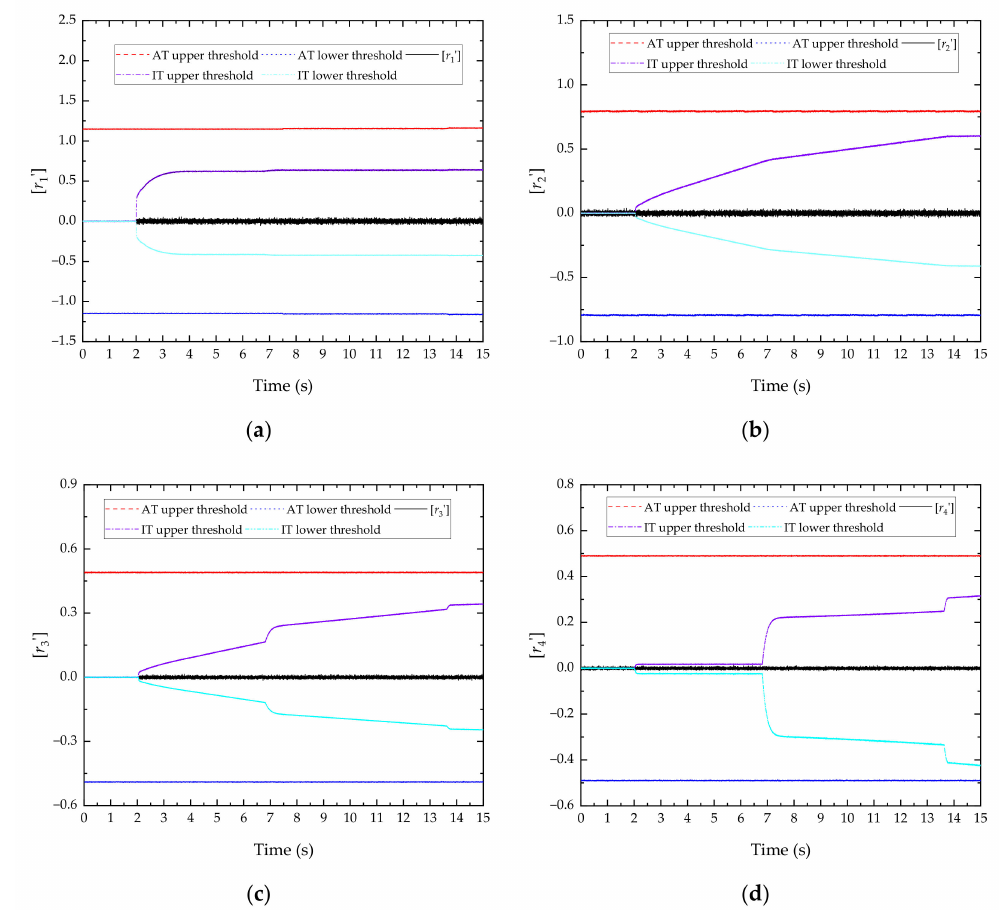
Figure 16. Fault free system operation fault detection results: ( a ) [ r 1 (cid:48) ] ( b ) [ r 2 (cid:48) ] ; ( c ) [ r 3 (cid:48) ] ; ( d ) [ r 4 (cid:48) ] .